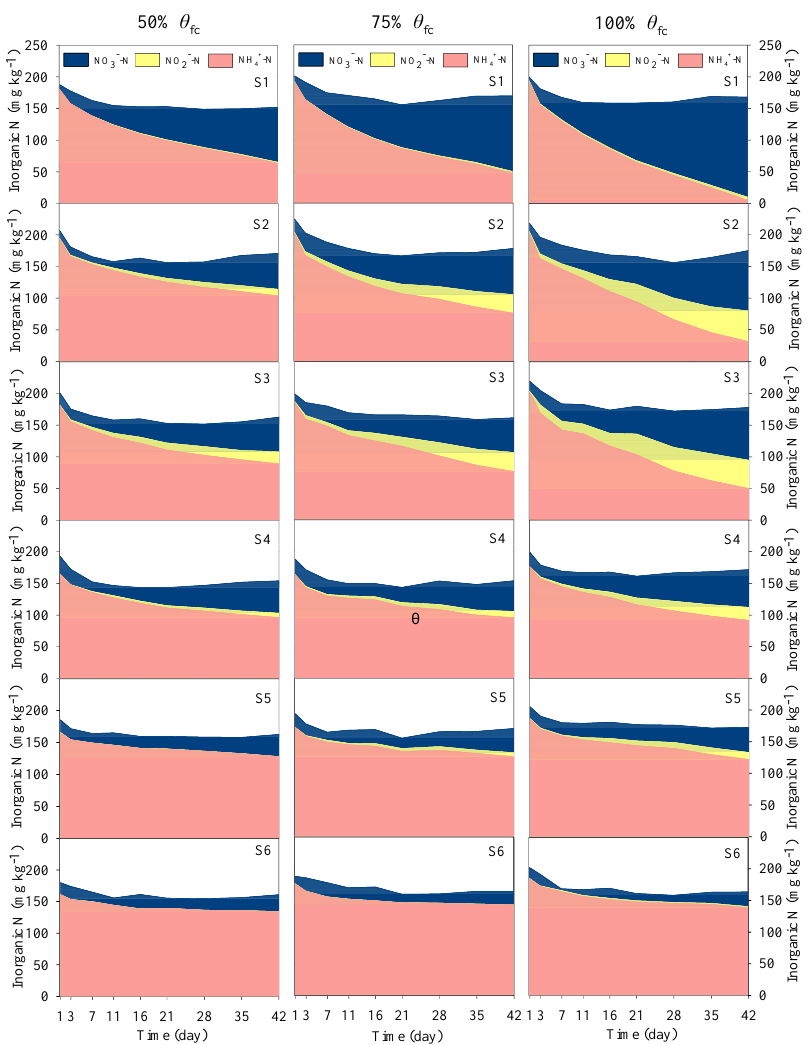
Figure 2. Soil NH 4 + -N, NO 2 − -N and NO 3 − -N concentrations in soil with di ff erent salinity levels at 50% θ fc , 75% θ fc and 100% θ fc . S1, S2, S3, S4, S5 and S6 represent six levels of soil salinity, 0.25, 1.01, 2.02, 3.21, 4.92 and 6.17 dS m − 1 , respectively. The width of color blocks represents the concentrations of NH 4 + -N, NO 2 − -N and NO 3 − -N respectively, each of which is the mean of three